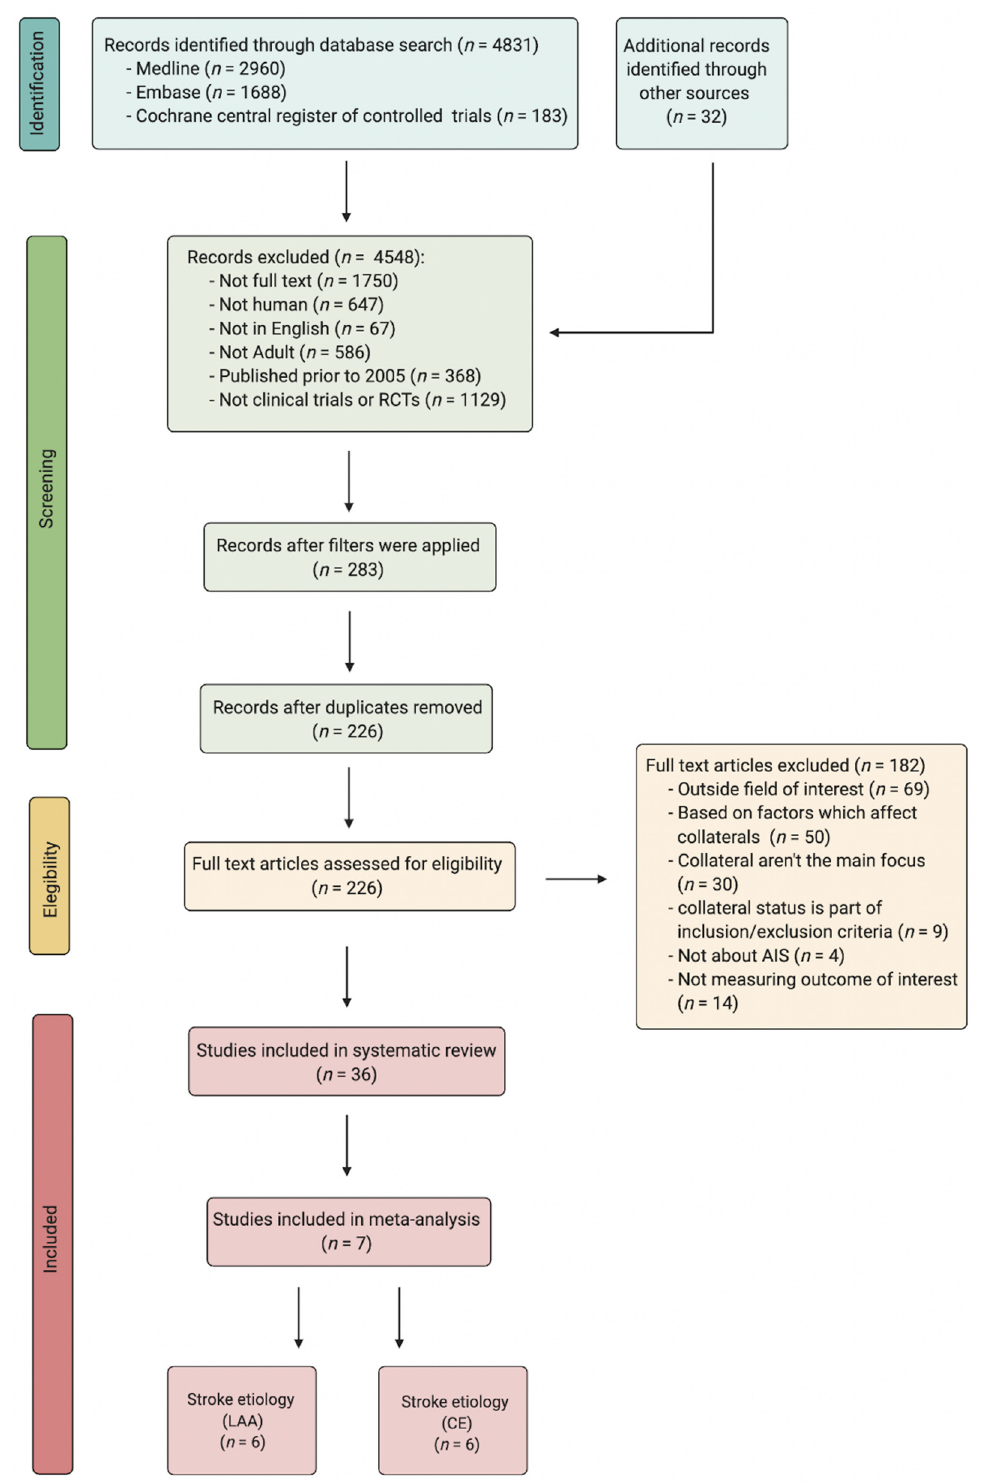
Figure 1. PRISMA flowchart detailing the process of finding and selecting studies for the meta- analysis. Abbreviations: RCT, randomised controlled trials; AIS, acute ischaemic stroke; LAA, large artery atherosclerosis; CE, cardio-embolism.